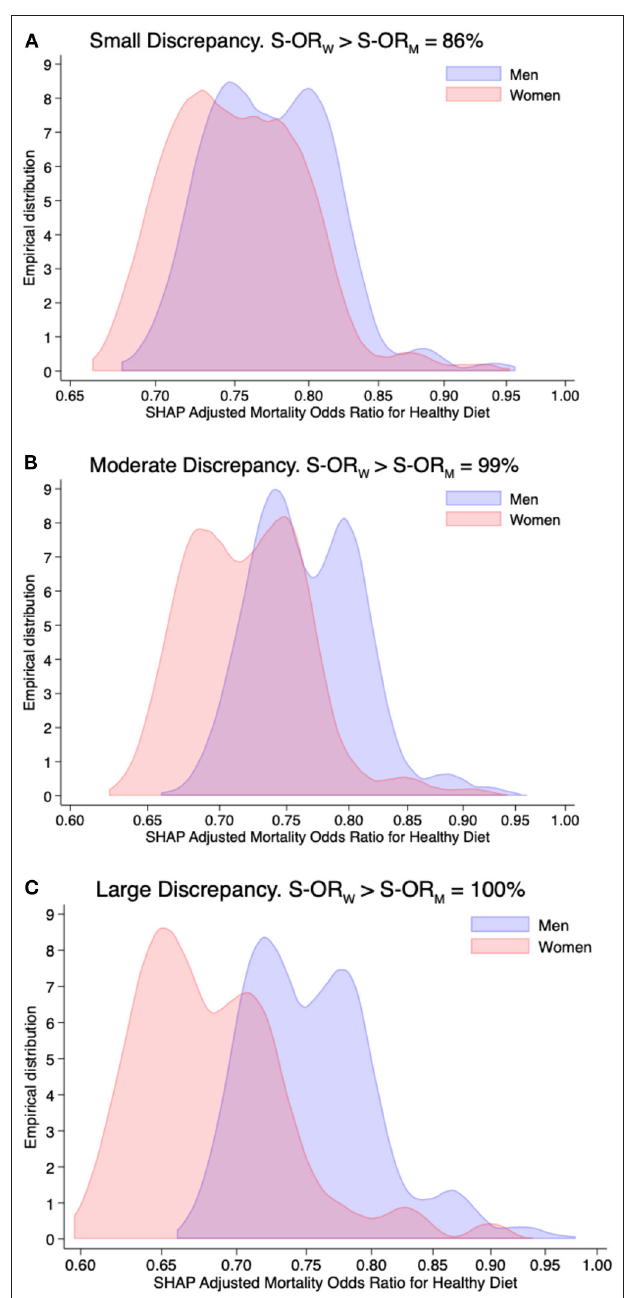
FIGURE 2 | Simulation study—small (A) , moderate (B) , and large (C) discrepancies by sex in the adjusted mortality adjusted odds ratio (on the log-scale) for healthy diet computed in 1,000 studies, each of size of 47,770 individuals and with SHAP values derived from extreme gradient boosting. The x-axis is on the log scale. The percentage indicated in the title is the fraction of times in which the SHAP-based adjusted mortality odds ratio among women (S-OR W ) is greater than men (S-OR M